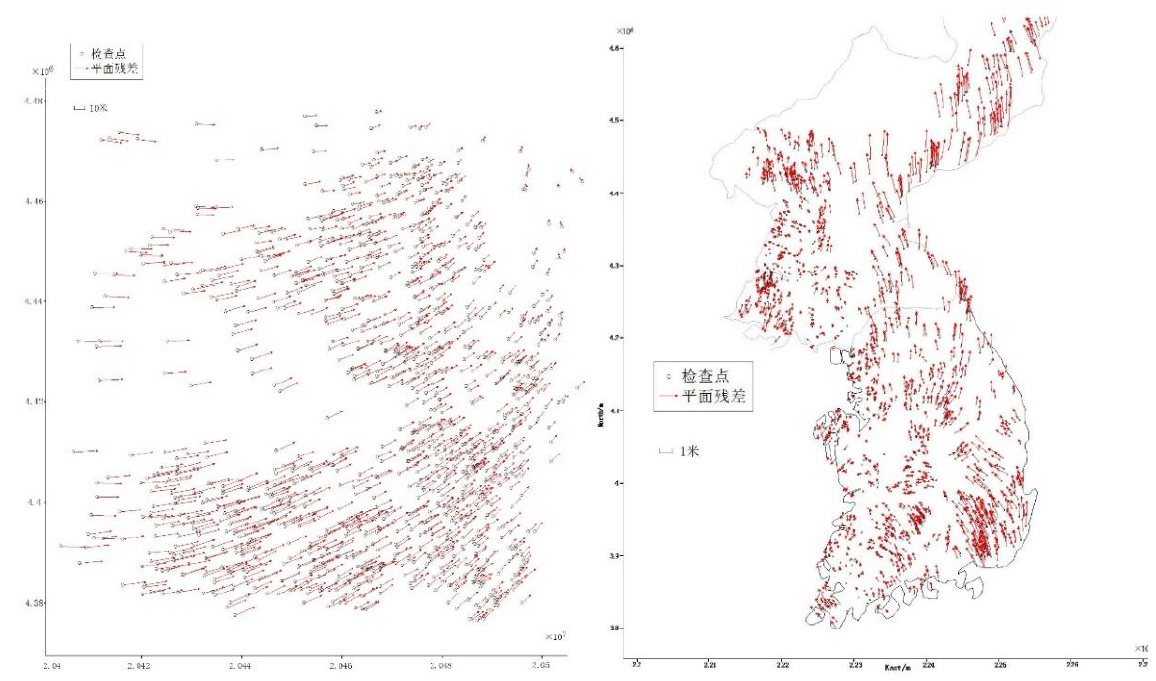
Fig 3: Test data 2: horizontal error distribution from 2200 check points for 1815 ZY-3 satellite images (605 three-line array and stereo images) (the scale of the error vector is 1 m)